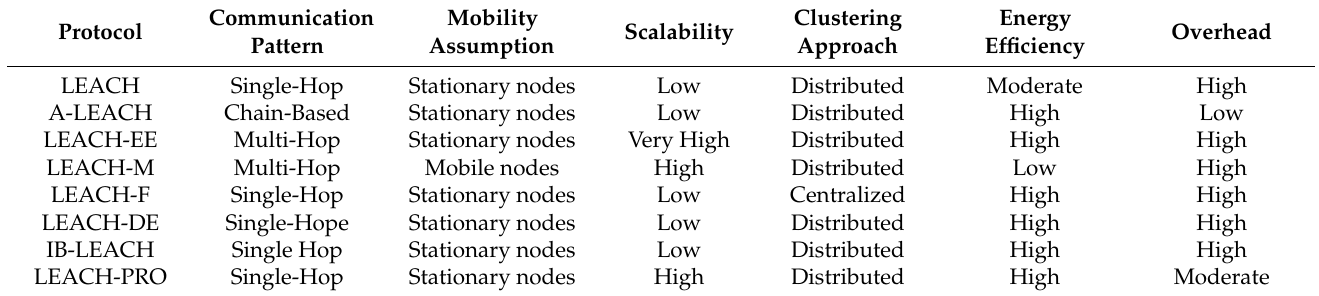
Table 3. Comparison of various extensions of LEACH